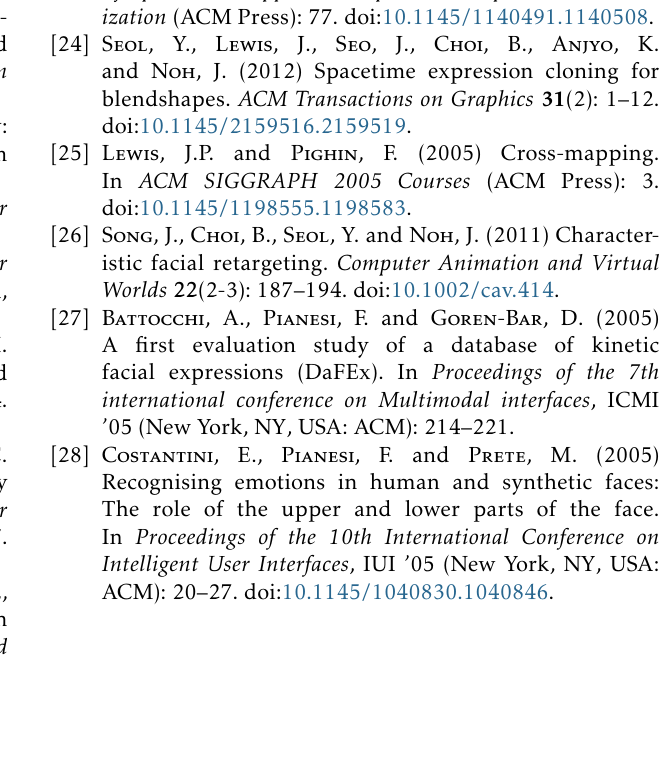
actor: The digital emily